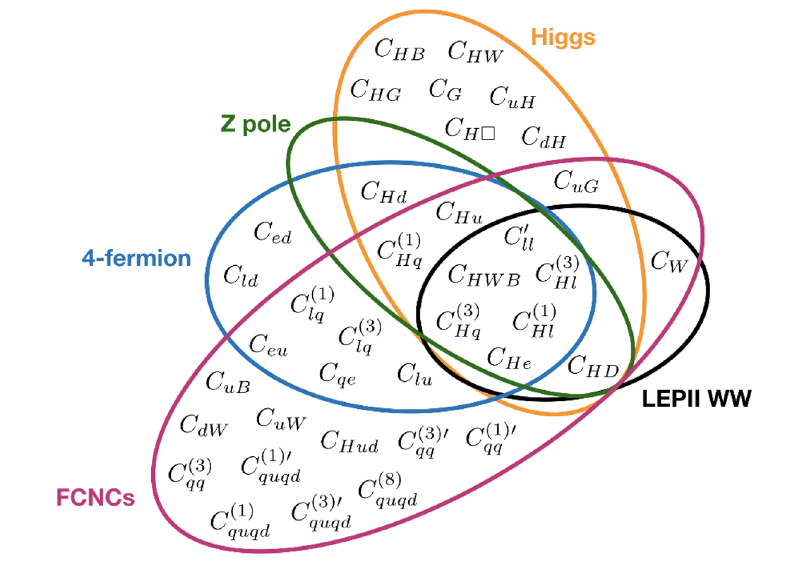
Figure 2. Diagram showing which Warsaw basis Wilson coefficients affect each of the types of observables included in the